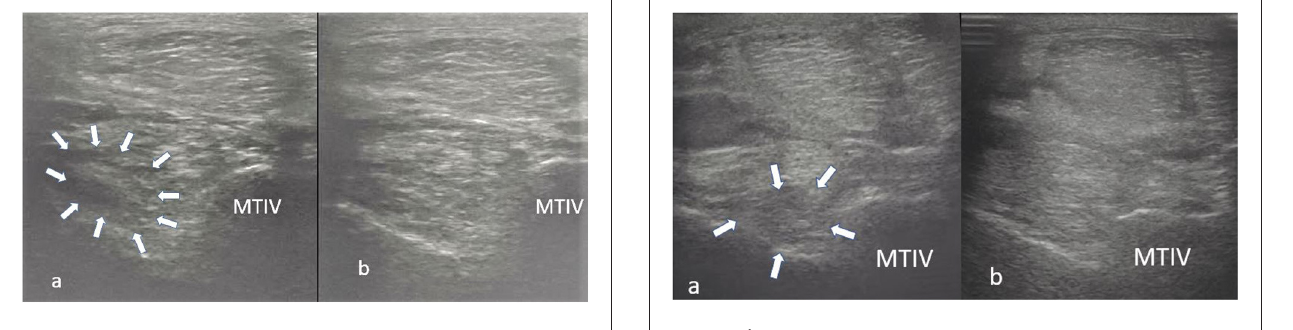
FIGURE 5 | Transverse images of a proximal suspensory ligament about 4cm distal to the head of the MTII. In panel (a) is the lesion (white arrows) before the treatment and in panel (b) 24 weeks after the treatment with LR-PRP. The healing is characterised by reduction of the hypoechogenecity of the lesion. This horse remained sound at the 18-month follow-up.